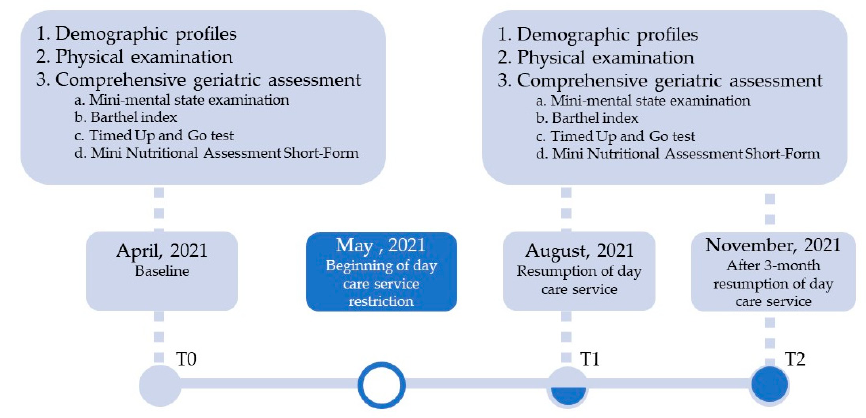
Figure 1. Overview of the study process and data collection periods.